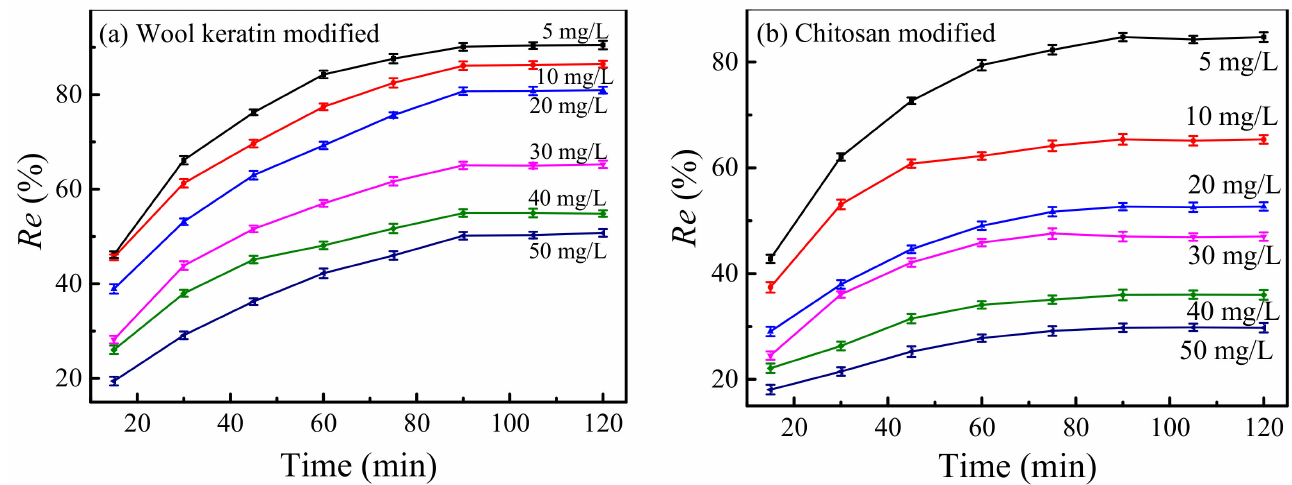
Figure 10. The effects of the initial Cu 2+ ions on the removal efficiencies of Cu 2+ ions by the ( a ) wool keratin modified and ( b ) chitosan modified Fe 3 O 4